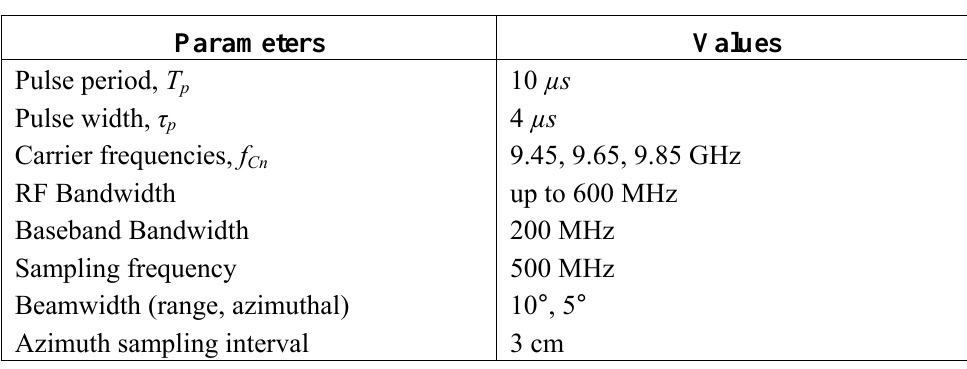
Table 1. The specification of